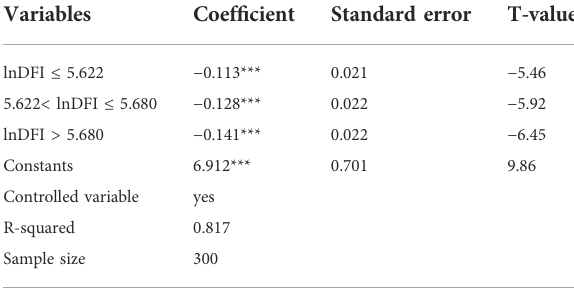
TABLE 10 Estimation results of the double threshold